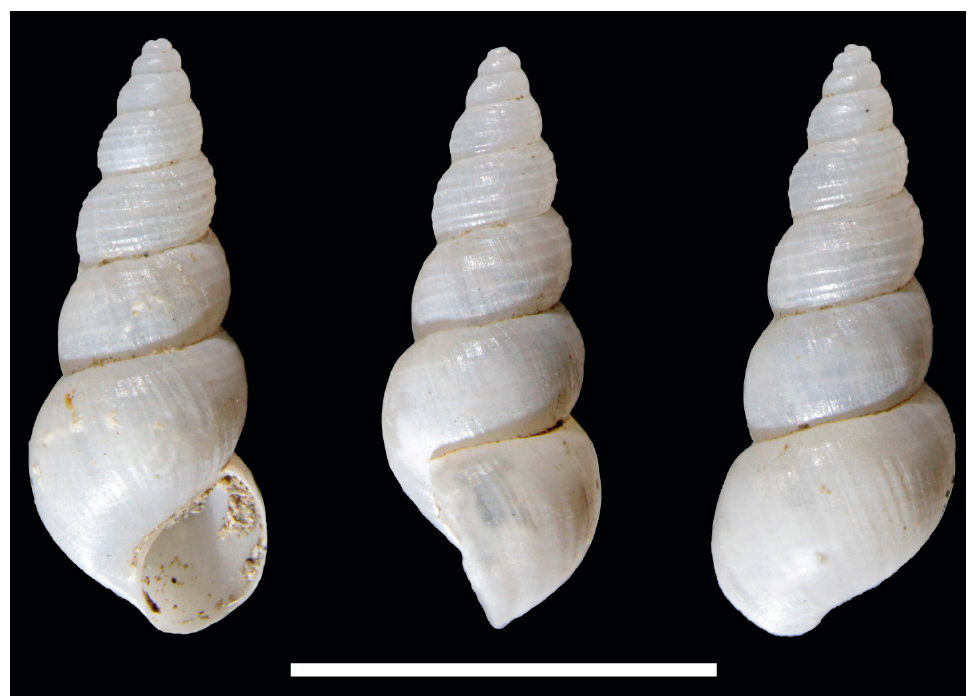
Figure 4. Specimen of Hawaiian Cochliopidae, Tryonia porrecta (Mighels, 1845) BPBM277027. Scale bar = 5 mm.